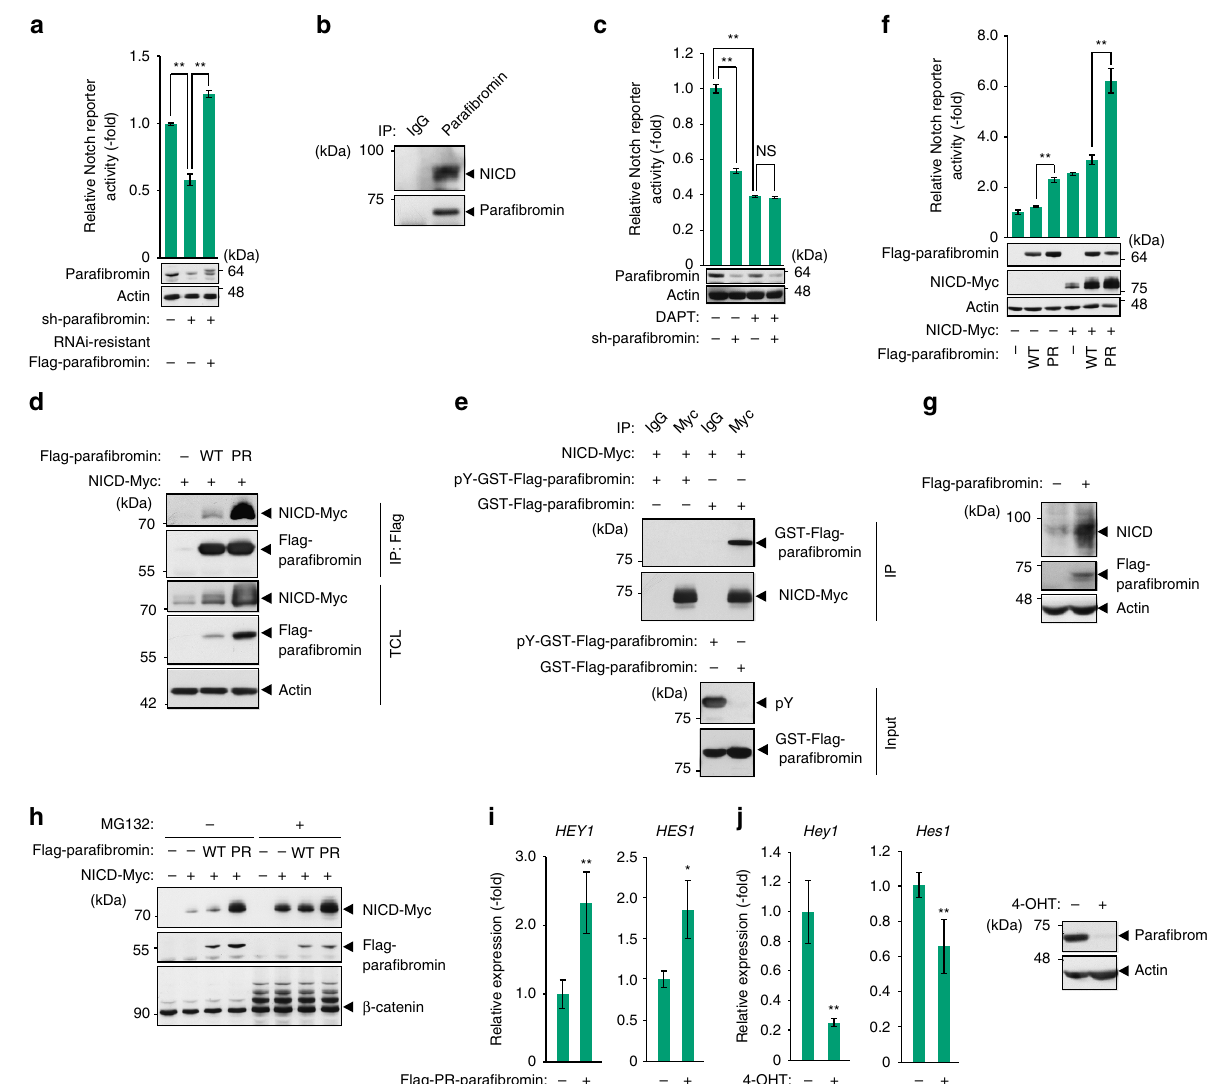
Figure 2 | Parafibromin acts as a transcriptional coactivator in Notch signalling. ( a ) Parafibromin knockdown results in reduced Notch signal activity. Notch-responsive luciferase reporter assays were performed in HEK293T cells. Total cell lysates (TCLs) were subjected to immunoblotting ( n ¼ 3, mean ± s.d. ** P o 0.01; ANOVA with Bonferroni’s post hoc test). ( b ) Parafibromin forms a complex with NICD. TCLs prepared from MCF7 cells were sequentially immunoprecipitated (IP) with an anti-parafibromin antibody and immunoblotted. ( c ) A g -secretase inhibitor (DAPT) treatment blocked the parafibromin-dependent Notch reporter activation. Notch-responsive luciferase reporter assays were performed in HEK293T cells. Cells were incubated with medium containing 100 m M DAPT for 48h ( n ¼ 3, mean ± s.d. ** P o 0.01; ANOVA with Bonferroni’s post hoc test). ( d ) Phospho-resistant (PR)-parafibromin shows increased NICD binding. HEK293Tcells were transfected with the indicated vectors. TCLs were sequentially immunoprecipitated (IP) and immunoblotted. ( e ) Non-phosphorylated parafibromin specifically interacts with NICD. HEK293Tcells were transfected with the indicated vectors. TCLs were immunoprecipitated with the indicated antibodies and immunoprecipitates (IP) were incubated with recombinant phosphorylated/non- phosphorylated parafibromin. The reaction mixtures were subjected to immunoblotting. ( f ) PR-parafibromin shows increased ability to activate Notch signalling. Notch-responsive luciferase reporter assays were performed in HEK293Tcells ( n ¼ 3, mean ± s.d. ** P o 0.01; ANOVA with Bonferroni’s post hoc test). ( g ) MCF7 cells were transiently transfected with a parafibromin expression vector. At 48h after transfection, TCLs were subjected to immunoblotting. ( h ) Parafibromin inhibits proteasome-dependent degradation of NICD. HEK293T cells were transfected with the indicated vectors and incubated with or without 10 m M MG132 for 8h. TCLs were immunoblotted with the indicated antibodies. ( i ) Expression of PR-parafibromin induces transactivation of Notch target genes. MCF7 cells were transfected with the indicated vectors and mRNA expression levels of HEY1 and HES1 were measured by RT–qPCR analyses ( n ¼ 4, mean ± s.d. * P o 0.05, ** P o 0.01; a two-tailed unpaired Student’s t -test). ( j ) Conditional deletion of parafibromin in Hrpt2 flox/flox MEFs was induced by 4-OHT treatment and expression levels of Hey1 and Hes1 were measured by RT–qPCR analyses ( n ¼ 3, mean ± s.d. ** P o 0.01; a two-tailed unpaired Student’s t -test). Parafibromin knockout was confirmed by immunoblotting.